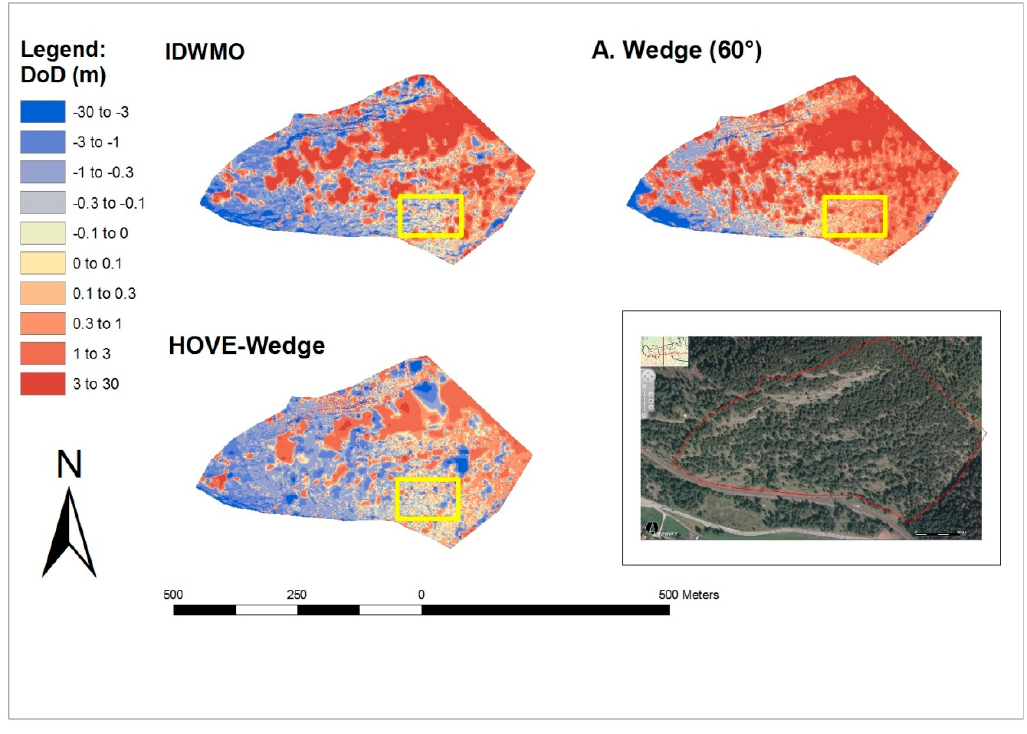
Figure 9. DoDs of different filtering methods and image source: © Land Tirol, tiris, www.tirol.gv.at/tiris. Table 1. Statistical values for the first test